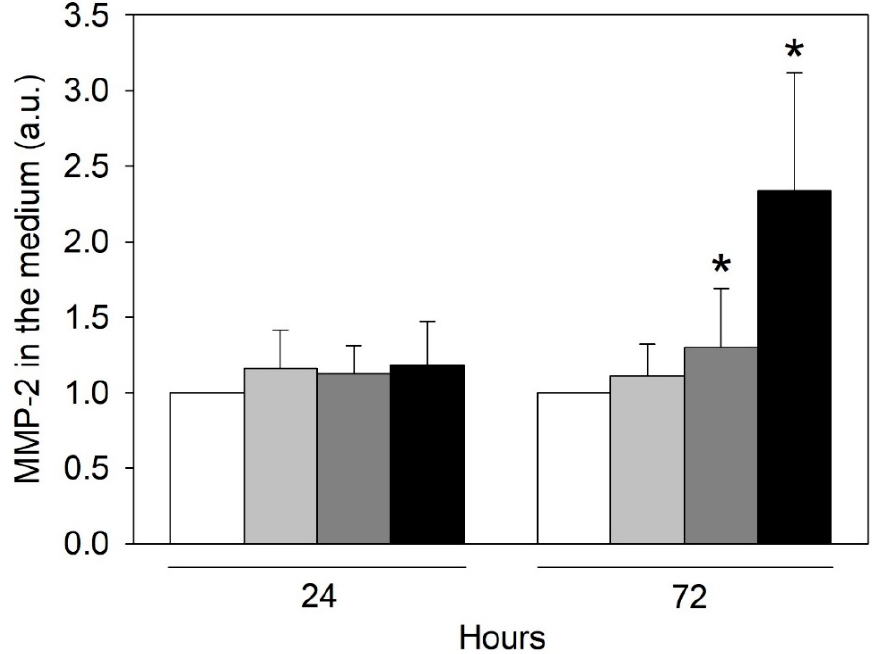
Figure 6. Effect of urea on the release of MMP-2 in the culture medium by HMEC-1. Histograms showing MMP-2 level measured in the culture medium of control cells and cells treated with 0.25, 2, or 5 g/L urea for 0, 24, 48, or 72 h. Data are expressed as the mean ± SD. * p < 0 05.